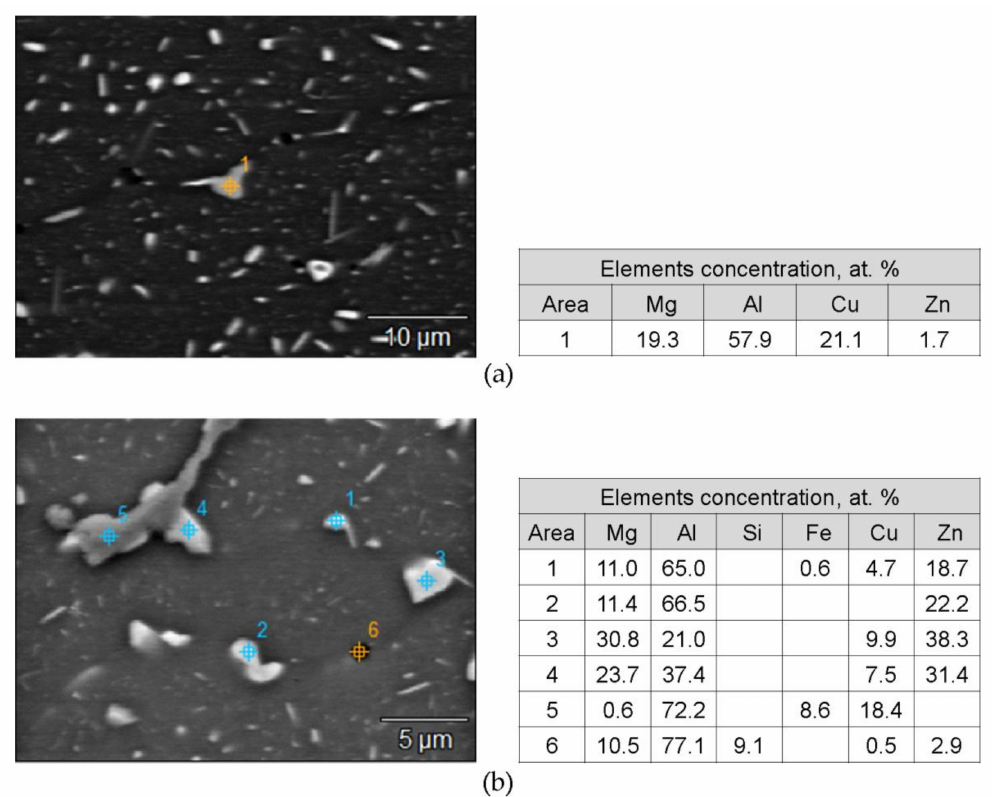
Figure 10. Particles observed in the alloys microstructure after cooling from the homogenization temperature at 60 ◦ C/h: ( a ) 7075 alloy 2; ( b ) 7049 alloy